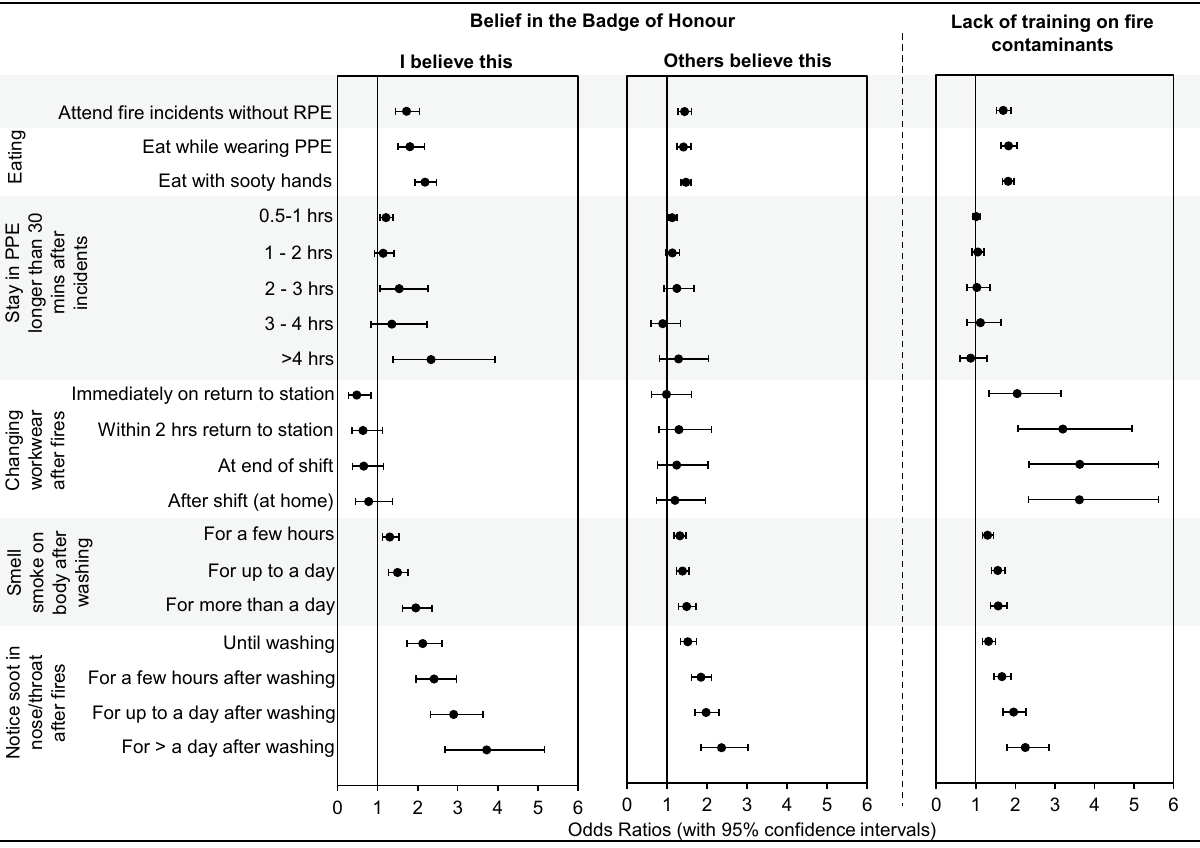
Figure 4. Crude odds ratios for engaging in behaviours/practices that lead to personal contamination during/after fire incidents for firefighters who believe in the BoH, or who have not received training on fire contaminants and their associated health outcomes